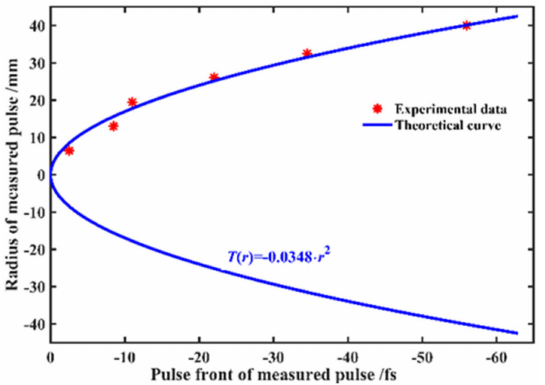
Figure 4. Measured data and theoretical curve of the pulse front distortion.